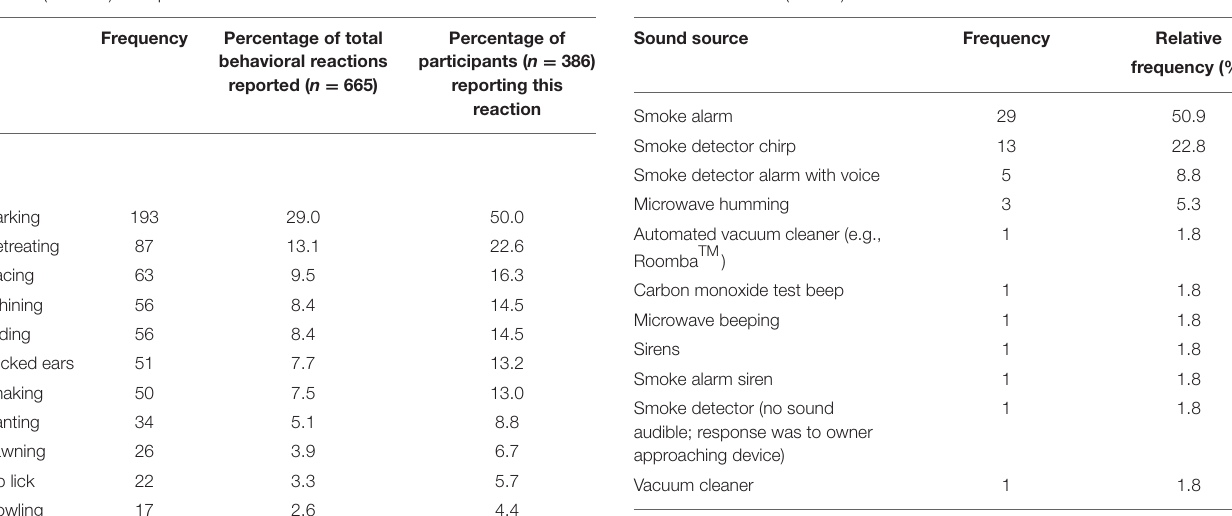
TABLE 5 | Descriptions of sound sources a causing stress-related dog reactions in the YouTube videos ( n =